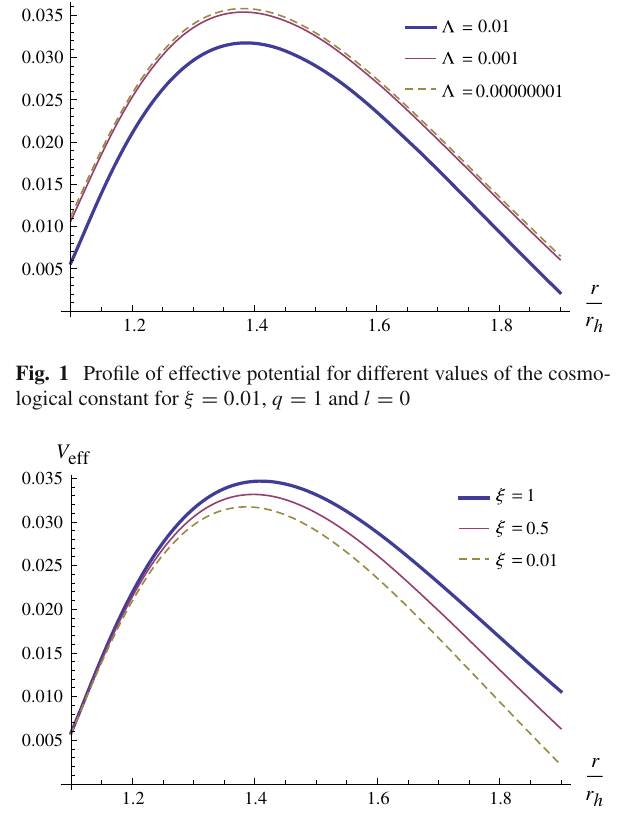
Fig. 2 Profile of effective potential for different values of the coupling constant for (cid:5) = 0 . 01, q = 1 and l =